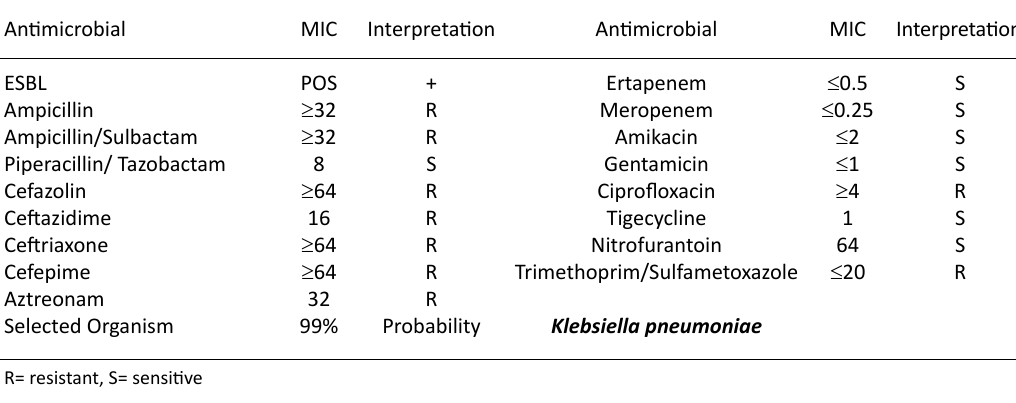
Table 1. Identification and antimicrobial susceptibility of Klebsiella pneumonia isolated from patient with pneumonia Antimicrobial MIC Interpretation Antimicrobial